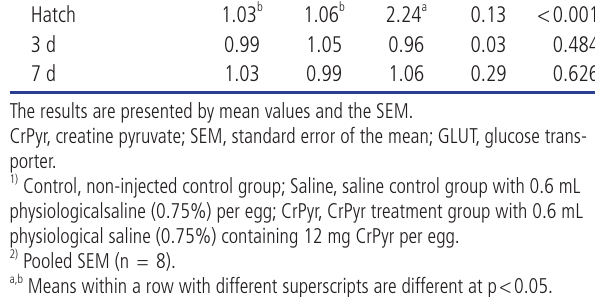
Table 6. Effects of in ovo feeding of creatine pyruvate on the creatine kinase activity in thigh muscle of em-bryos and broilers on 2 d after injection, the day of hatch, 3, and 7 d post-hatch (U/mg of protein) Treatment 1) Item SEM 2)